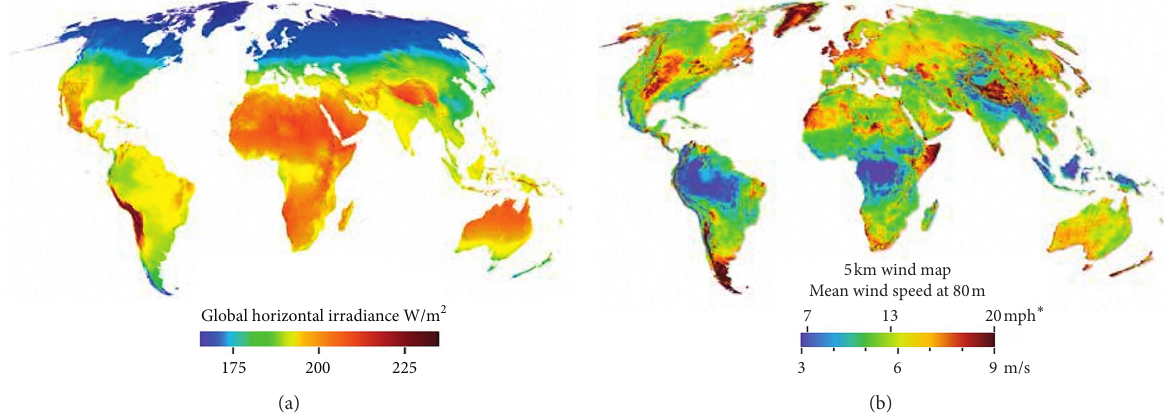
Figure 5: (a) World solar potential [28]. (b) World wind potential [10].